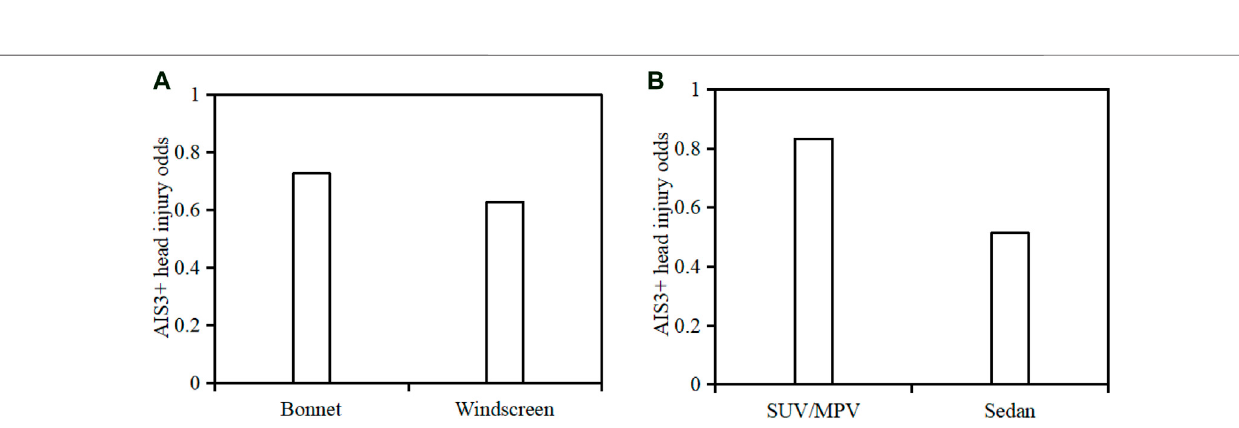
( Figure 11C ). The results also show that the WAD is in fl uenced by pedestrian height and vehicle impact velocity, where a positive linear correlation is observed for the relationship between pedestrian WAD/height ratio and vehicle impact velocity ( Figure 11D ). These fi ndings could provide evidence for estimation of pedestrian head contact time and location from accident scenarios.